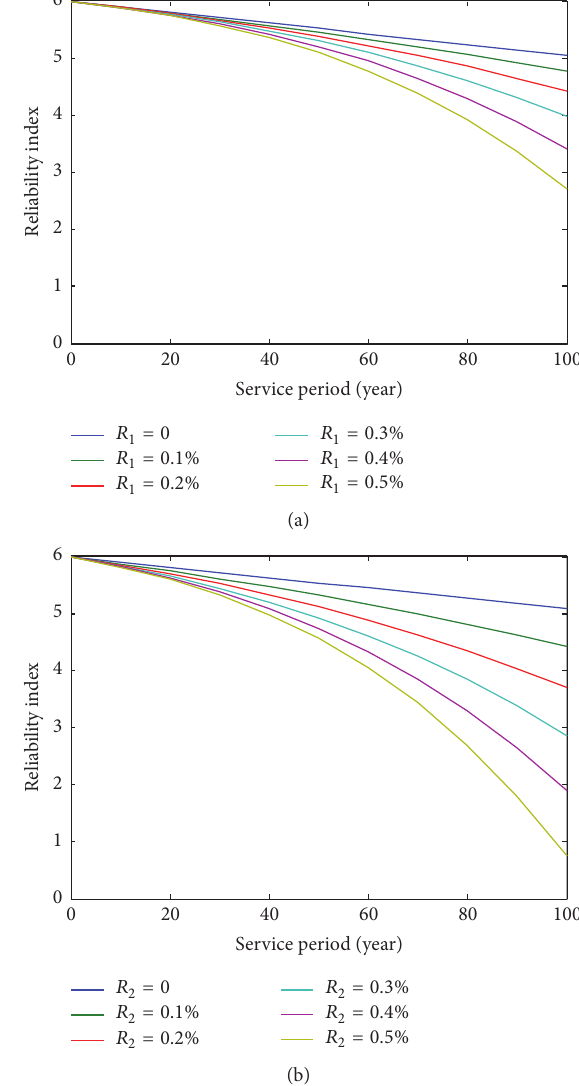
𝑅 1 indicates the growth rate of ADTT and growth rate of GVW.